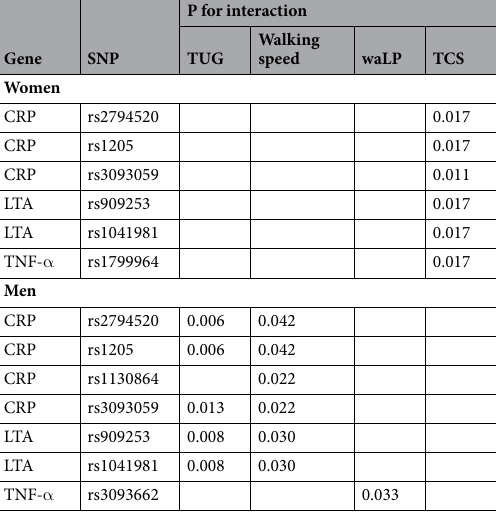
five haplotypes of CRP genes and three of LTA genes in women for analysis (Table 4). Three haplotypes of CRP gene were prevalent, and the other two CRP haplotypes were less common with estimated frequencies of 9.73%